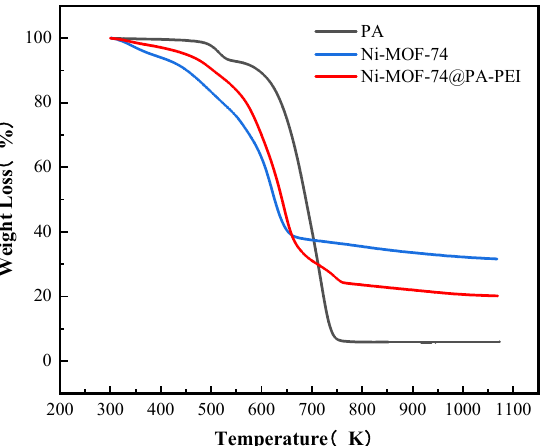
Figure 9. Thermal analysis results of PA, PA−PEI, Ni−MOF−74, and Ni−MOF−74@PA−PEI.